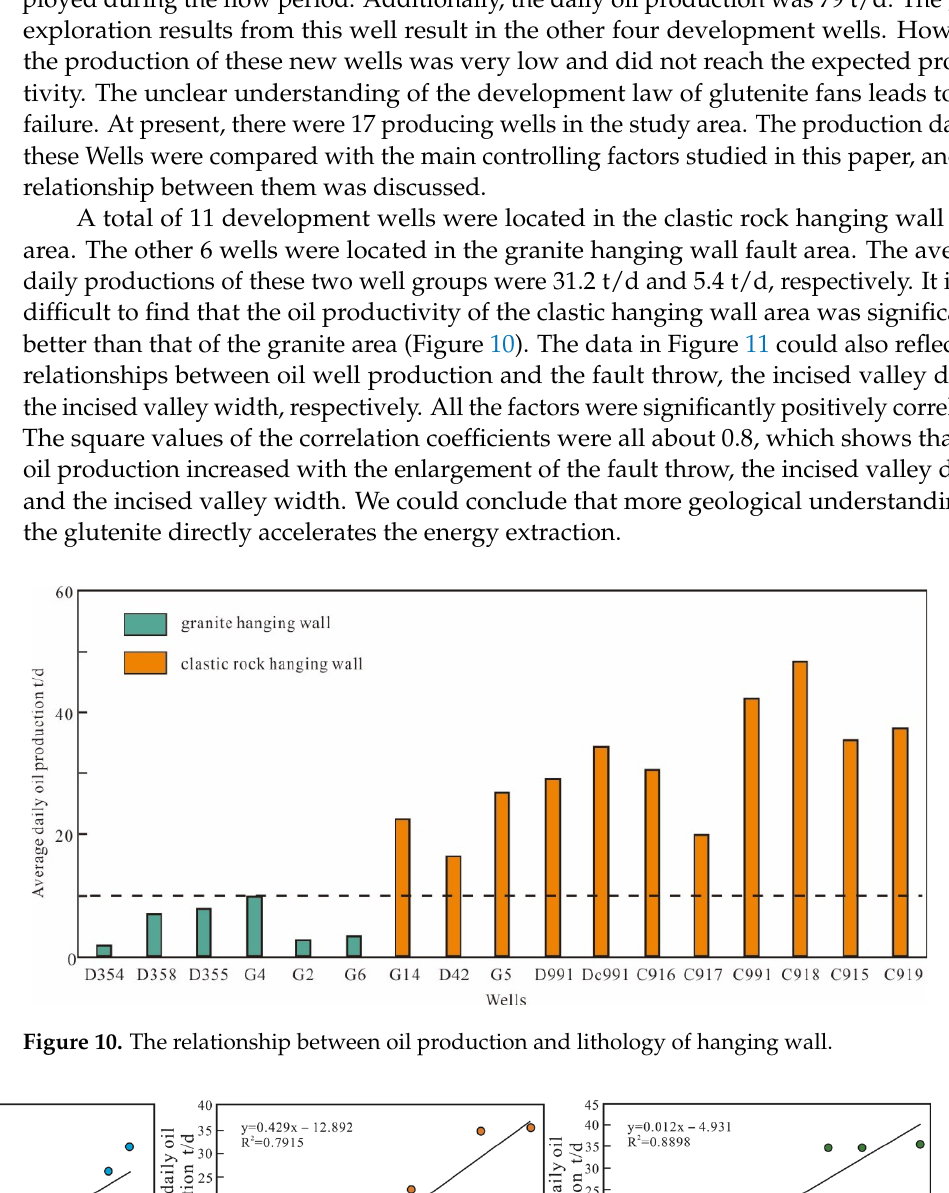
Table 7. Comprehensive evaluation standard of glutenite reservoir in the Guojuzi area.